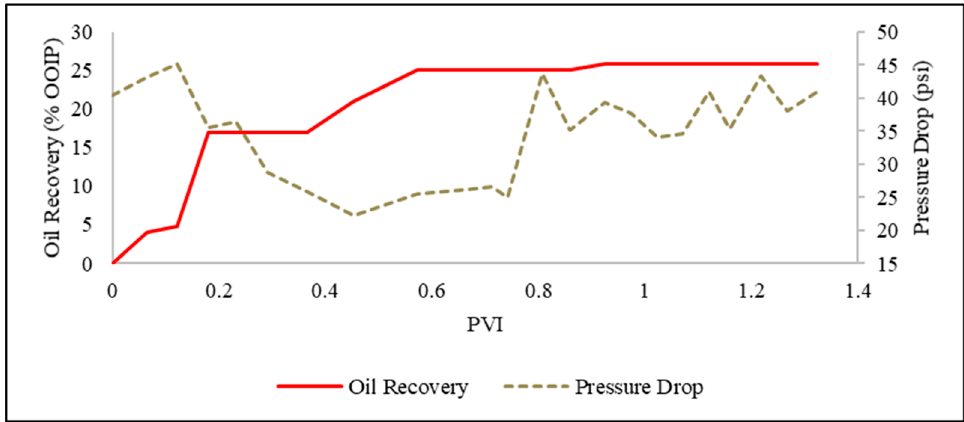
Figure 12. Oil recovery and pressure response for Copper Ridge dolomite miscible CO 2 flood.